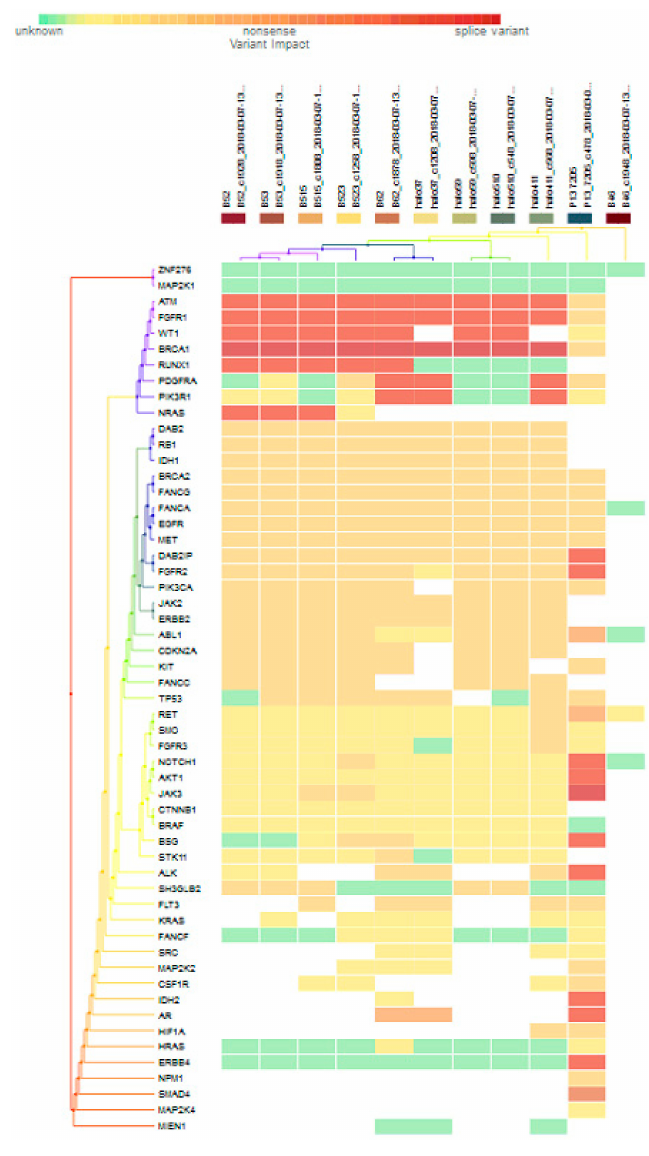
Figure 4. Heat map for 11 HR+/HER2+ subtype breast cancer. The variants impacted for 11 HR+/HER2+ breast cancers were INDELs. Frameshift: ATM, FGFR1 (10), WT1 (7), RUNX1 (5), PDGFRA, PIK3R1, NRAS(3), DAB2IP, FGFR2 , NOTCH1, AKT1, BSG, ALK, IDH2, AR, ERBB4 (1); non- frameshift: ABL1 (1), RET (1), AR (2); SNPs splice: BRCA1 (9), JAK3 (1); stop loss: SMAD4 (1); missense: ATM , FGFR1 , BRCA1 , PDGFRA (2), DAB2, RB1, DH1 (9), BRCA2, FANCG, FANCA, EGFR, MET (10), DAB2IP (9), FGFR2 (8), PIK3CA, JAK2, ERBB2 (9), ABL1 (7), CDK2NA, KIT (8), FANCC, TP53 (7), RET, SMO, FGFR3, NOTCH1 (1), JAK3, BSG (2), STK11 (1), ALK (3), SH3GLB2, FLT3 (5), MAP2K2, CSF1R (1), HIF1A (2), NPM1